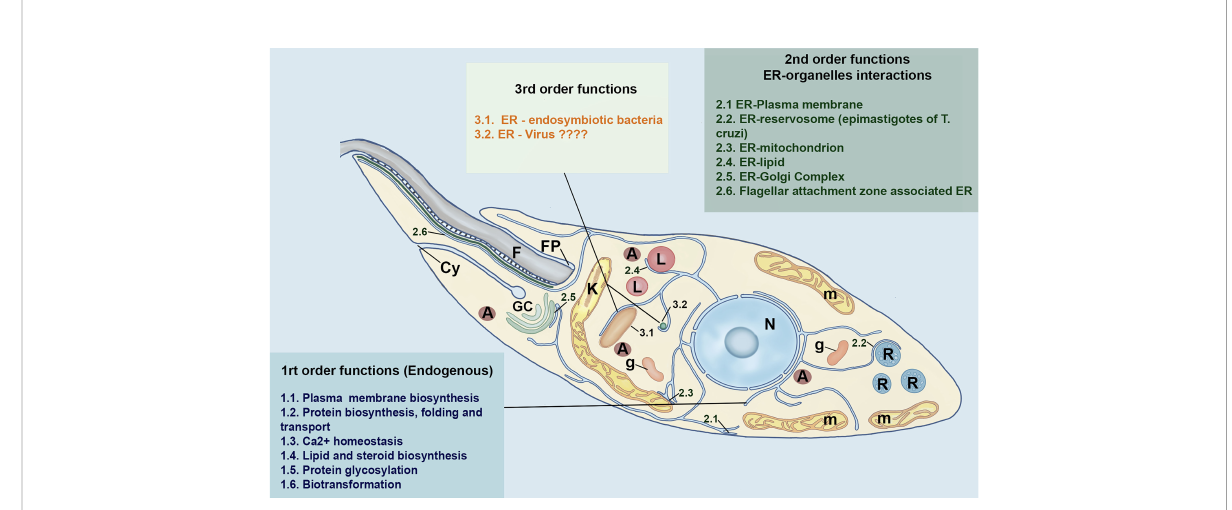
FIGURE 3 Schematic model of different functional niches of ER in Trypanosomatids based on Almeida (2021) model of a fi rst, second and-third-order functional hierarchy for higher eukaryotic cells. The fi rst-order functions are related to endogenous functions of the ER. The second-order is concerned with the interaction of ER with other organelles, whereas the third order includes the putative interaction of the trypanosomatid´s ER with bacteria and viruses. The main organelles of trypanosomatids are also represented. N, nucleus; A, acidocalcisomes, GC, Golgi Complex; L, lipid inclusions; m, mitochondrion; FP, Flagelar Pocket; F, Flagellum; g, Glycosomes, Cy, cytotostome and R, Reservosomes. This freehand digital illustration was made using Procreate ® and Adobe Photoshop ®